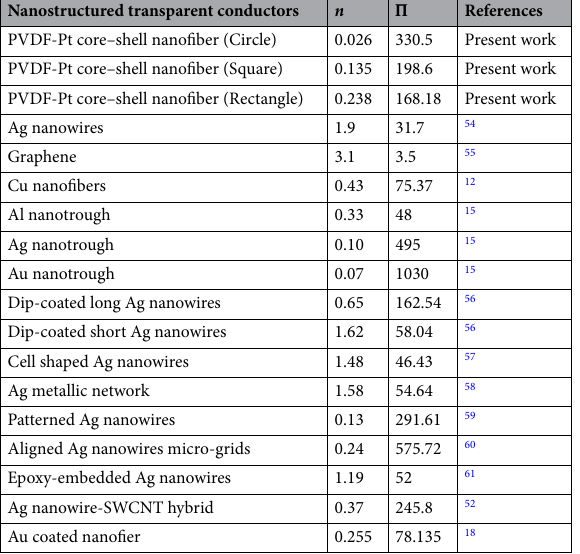
Table 1. Percolation exponents ( n ) and figures of merit (�) of the CS NF networks fabricated in this study and those of the nanostructured transparent conductors reported in previous studies 12,15,18,52,54–61 . In comparison with those reported in earlier studies, the PVDF-Pt CS NF network prepared using the circular electrode collector exhibits an outstanding performance as a transparent conductor because of its large percolation figure of merit (� = 330.5 ) and small percolation exponent ( n = 0.026 )